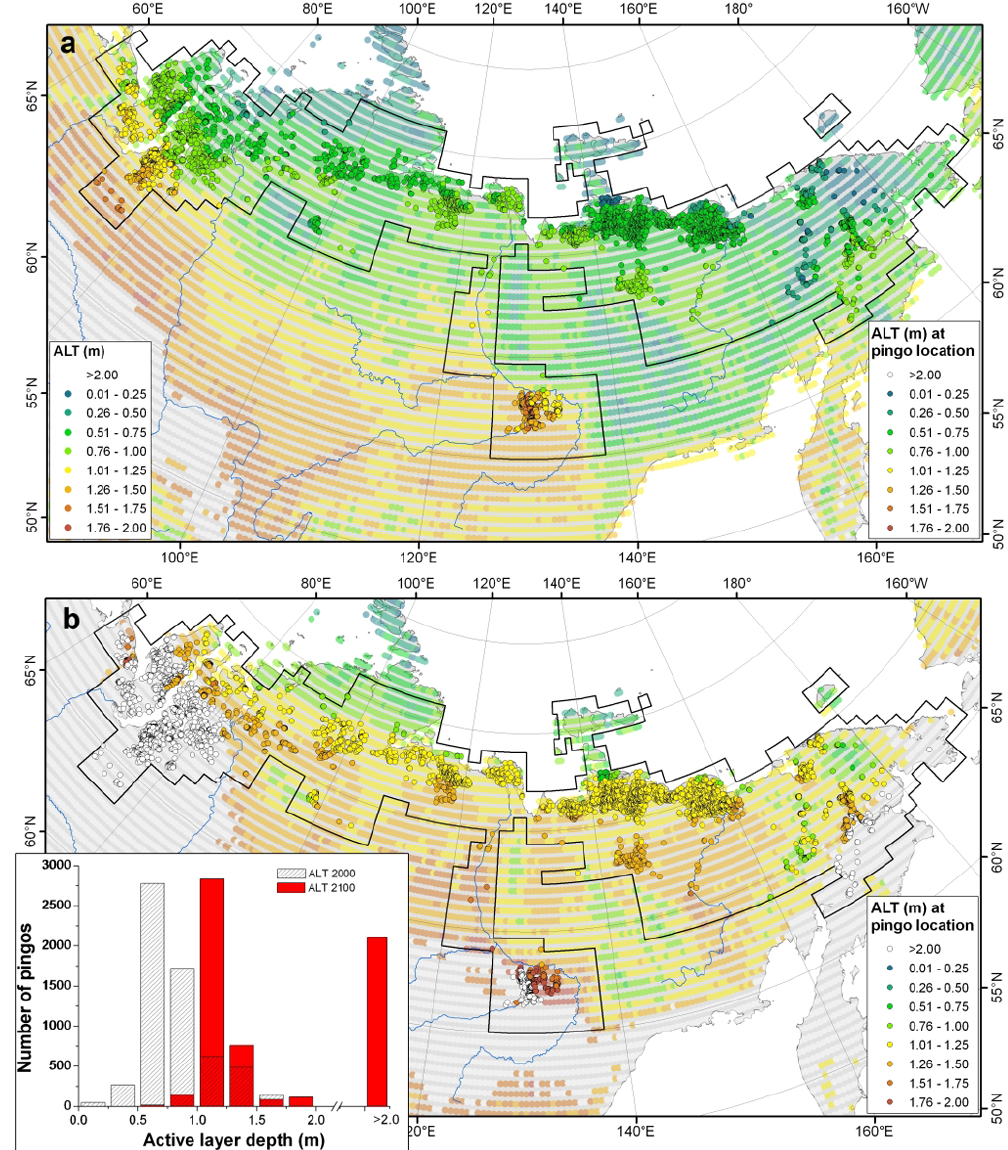
Fig. 13. Distribution of pingos by maximum active layer thickness (ALT) as modeled for the period (a) 1990–2000 and (b) 2090–2100 by Romanovsky et al. (2008). Histogram shows the shift of pingo populations from regions with ALT ranging from 0.25–1.5m to ALT ranging from 0 . 75 − > 2m by the end of the 21st